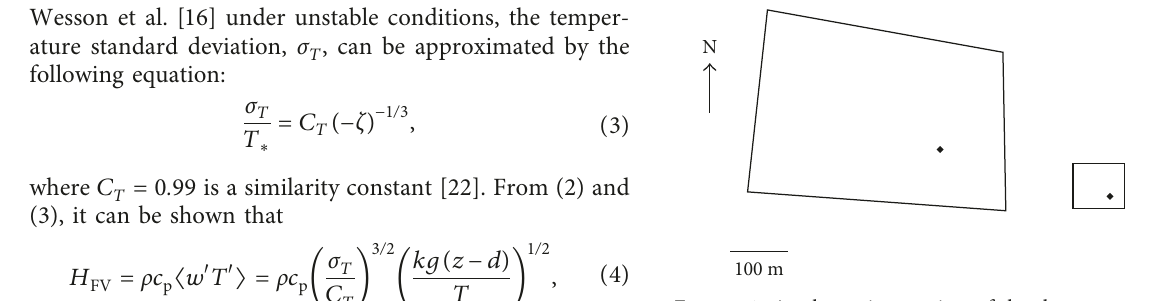
Figure 1: A schematic top-view of the three structures examined. The diamond symbol represents the location of the eddy-covariance and flux-variance sensors. From left to right: S1, banana screenhouse; S2, pepper screenhouse; S3, tomato